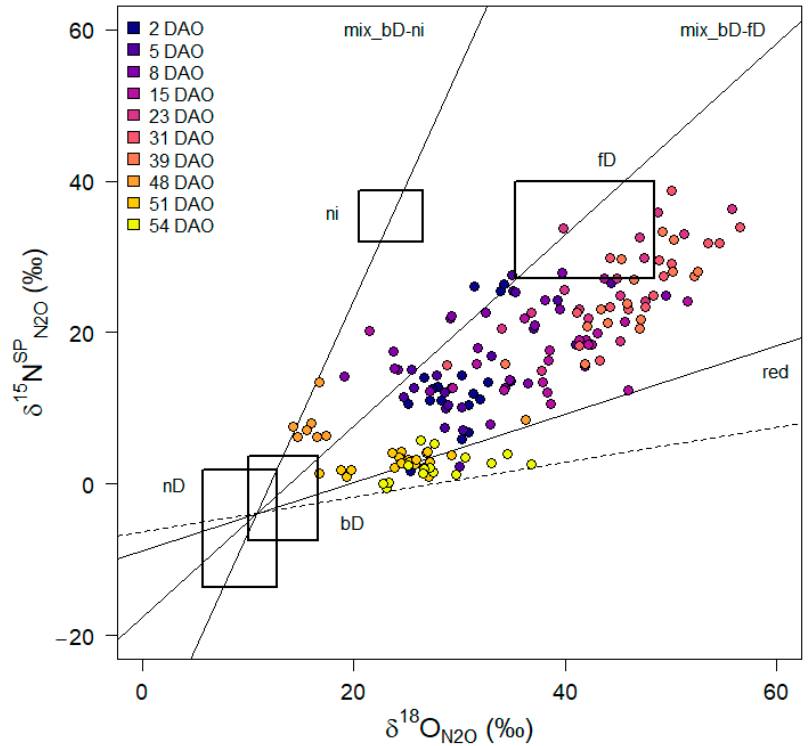
Figure 3. Isotopocule values of soil-emitted N 2 O per day plotted in the isotopocule map based on Lewicka-Szczebak et al. (2017) [22] and Yu et al. (2020) [23]. Boxes indicate the mean ranges for end-member values of δ 15 N SP N2O and δ 18 O N2O (corrected for δ 18 O H2O ) for heterotrophic bacterial denitrification (bD), nitrifier denitrification (nD), nitrification (ni), and fungal denitrification (fD) (view Table S1 for details). The mixing line connects the mean values of bD and fD (mix_bD-fD) or bD and ni (mix_bD-ni), respectively. The slope of the reduction lines (red) is based on the isotopic fractionation factor associated with N 2 O reduction to N 2 . Dashed line represents the minimum reduction line (n = 178, oxic incubation conditions from 0 DAO to 46 DAO, anoxic incubation conditions from 47 DAO to 55